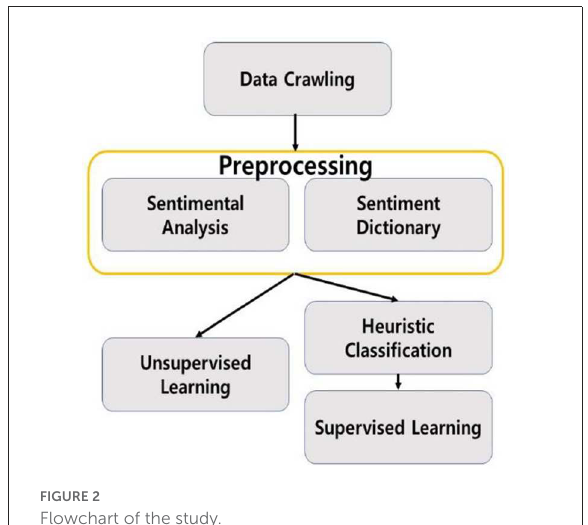
FIGURE2 Flowchart of the